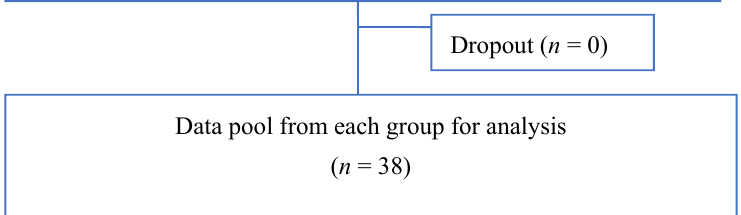
Figure 1. Flow diagram of participants.